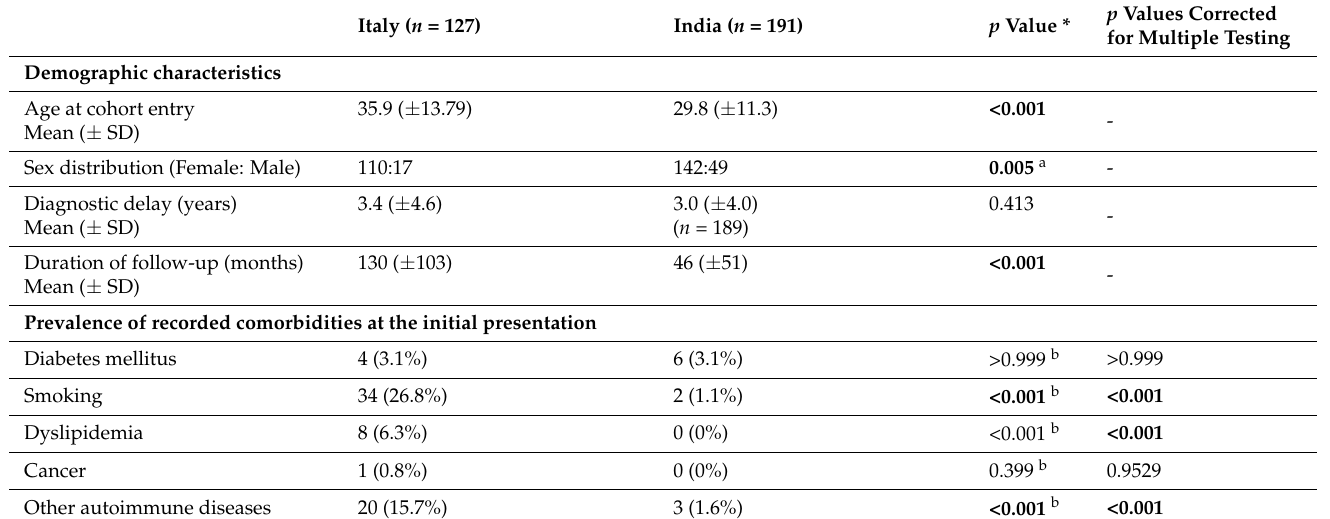
Table 1. Characteristics of the